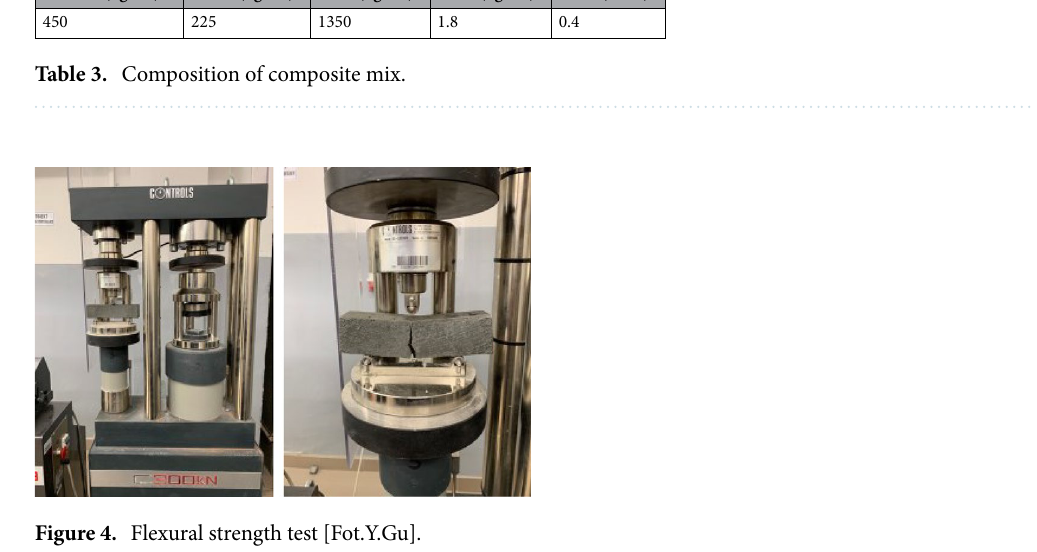
Figure 4. Flexural strength test